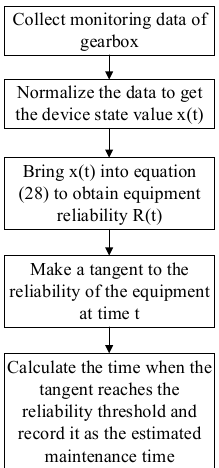
Figure 4. Calculation method of the estimated maintenance time.